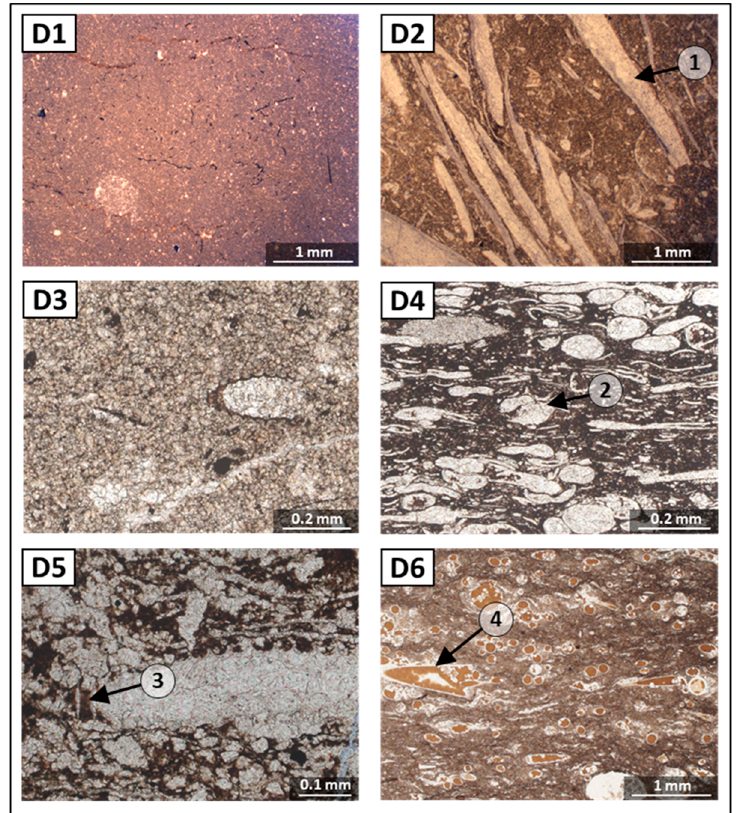
Figure 2. Thin section images of the main lithotypes. D1—micro-clotted limestone with